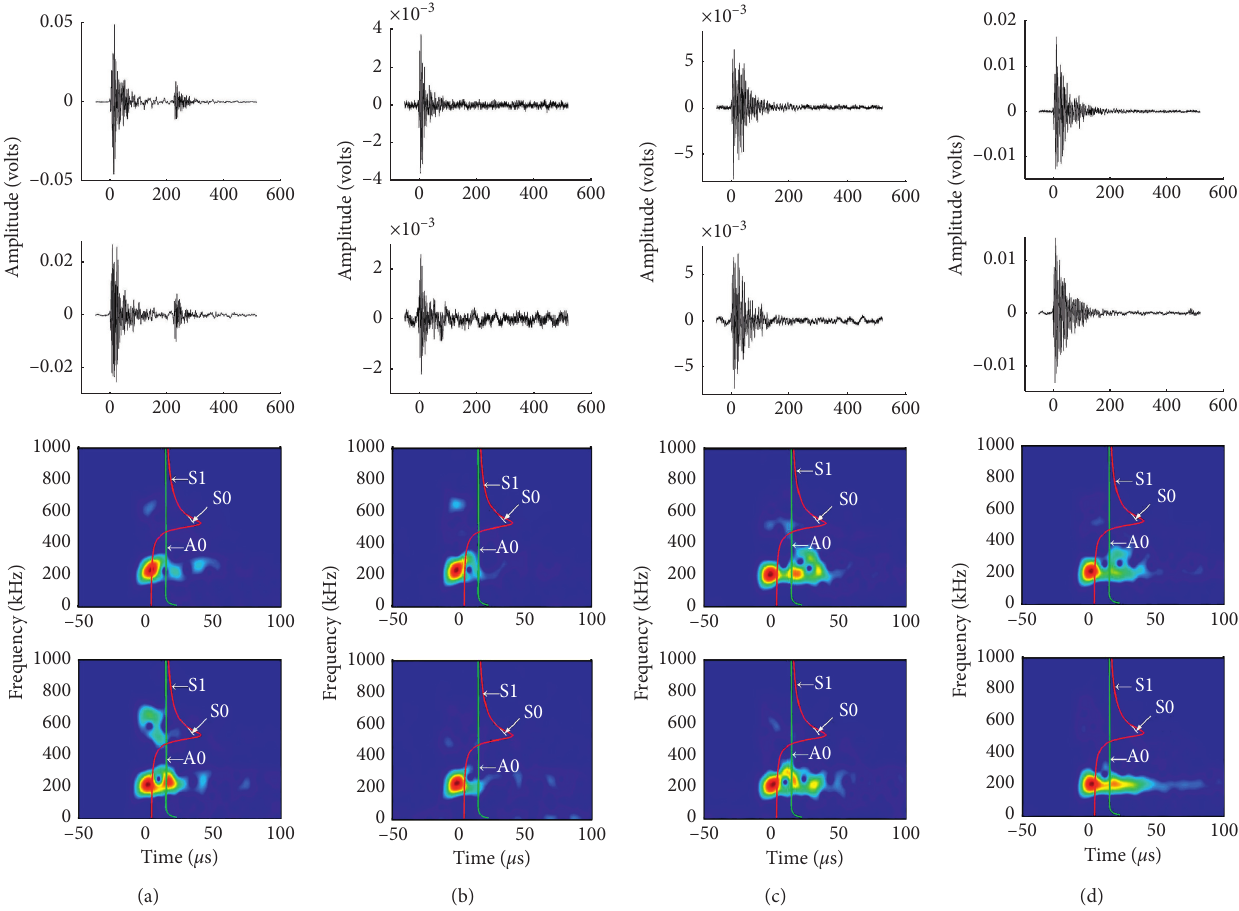
Figure 9: The AE waveform signal and spectrogram in a [90/0/90/0/90